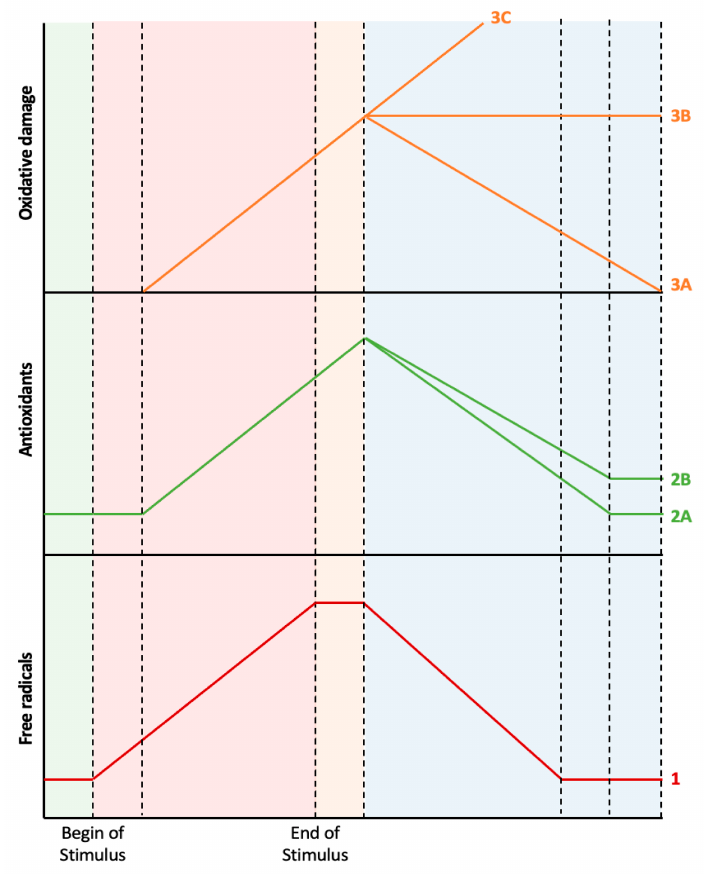
Figure 1. From oxidative stress to oxidative damage: chronological aspects. In homeostatic conditions (the green-shaded area), there is a small amount of ROS that acts as signaling molecules, and the corresponding antioxidant systems maintain ROS at physiological levels. When a prooxidant stimulus appears (pink-shaded area), ROS levels increase, and, therefore, the antioxidant defenses will also increase, but with some delay. During this phase, ROS levels are higher than the antioxidant defenses, thus leading to oxidative stress, which, in turn, will lead to oxidative damage to biomolecules. All these factors (ROS, antioxidant defenses, and oxidative damage to biomolecules) will continue to increase while the stimulus exists. When the stimulus disappears (orange-shaded area), ROS levels will no longer increase, but the remaining ROS molecules will continue to stimulate the antioxidant system and damage molecules. During this phase, there is no more imbalance between ROS and antioxidants, thus, there is no oxidative stress, even though there is still oxidative damage to biomolecules. Finally, the organism aims to return to homeostasis (blue-shaded area), but the antioxidant defenses can decrease to the previous levels or stay elevated as an adaptive response. Similarly, the oxidative damage to biomolecules can be repaired by autophagy or can be accumulative and even irreversible (probably leading to cell